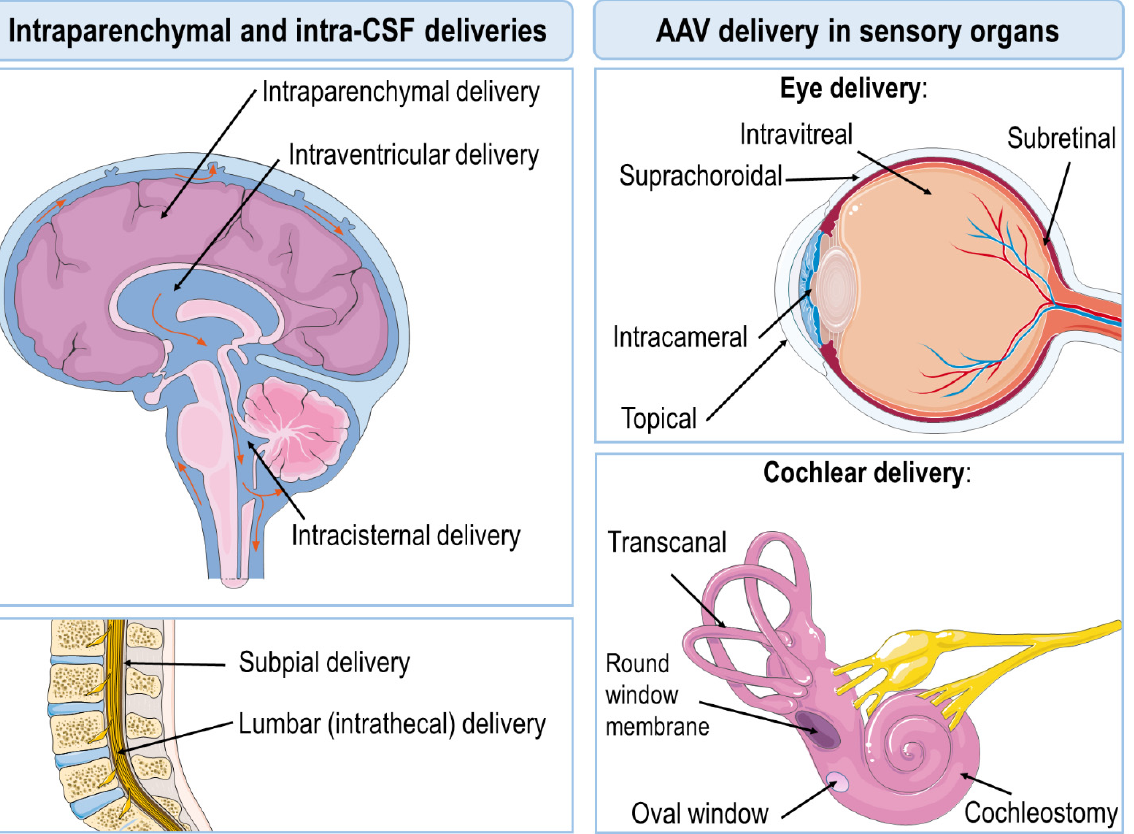
Figure 1. Illustration of most commonly used AAV delivery routes. For CNS diseases (e.g., Parkinson, Alzheimer, Huntington), the intraparenchymal administration of viral particles is by far the strategy most commonly used, followed by intra-CSF administration (intraventricular, intracisternal, and intrathecal). Several ongoing gene therapy studies are focused on targeting blindness and deafness disorders, and, in these scenarios, eye delivery (e.g., subretinal, intravitreal, intracameral, etc.) and ear delivery (e.g., cochleostomy or RWM) have proven preclinical success.